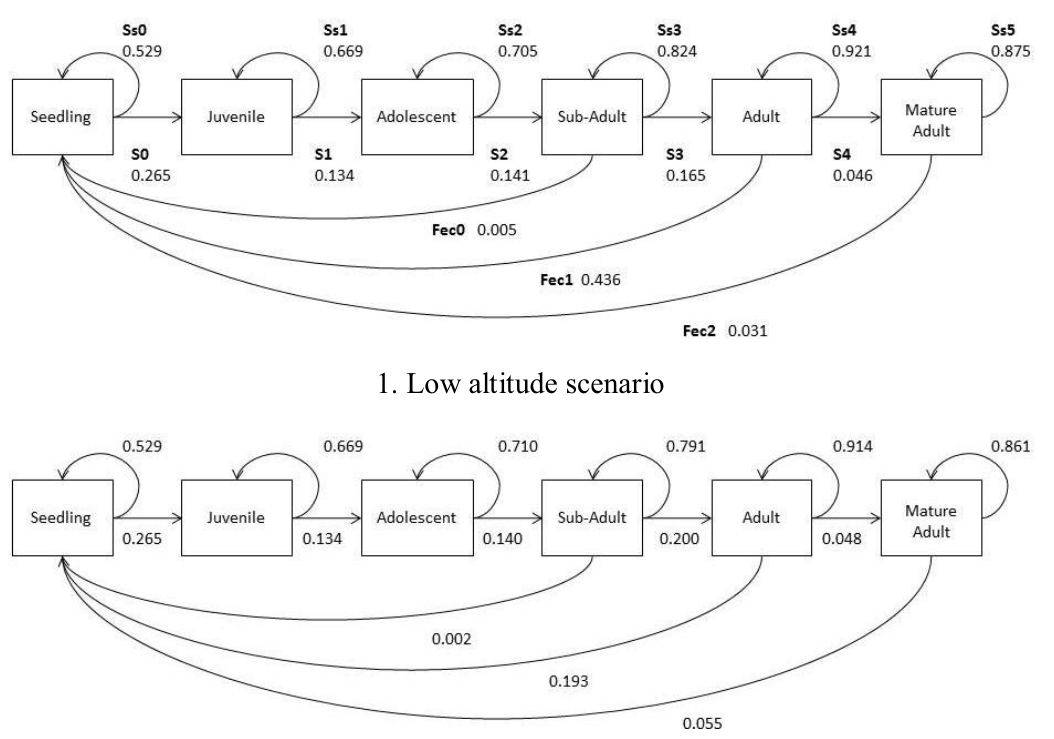
Figure 6. The lifecycle diagram of H. canterburyana on Lord Howe Island, and values previously calculated for matrix table. Ssn , stage-specific survival rate; Sn , transition survival rate; and Fecn ,